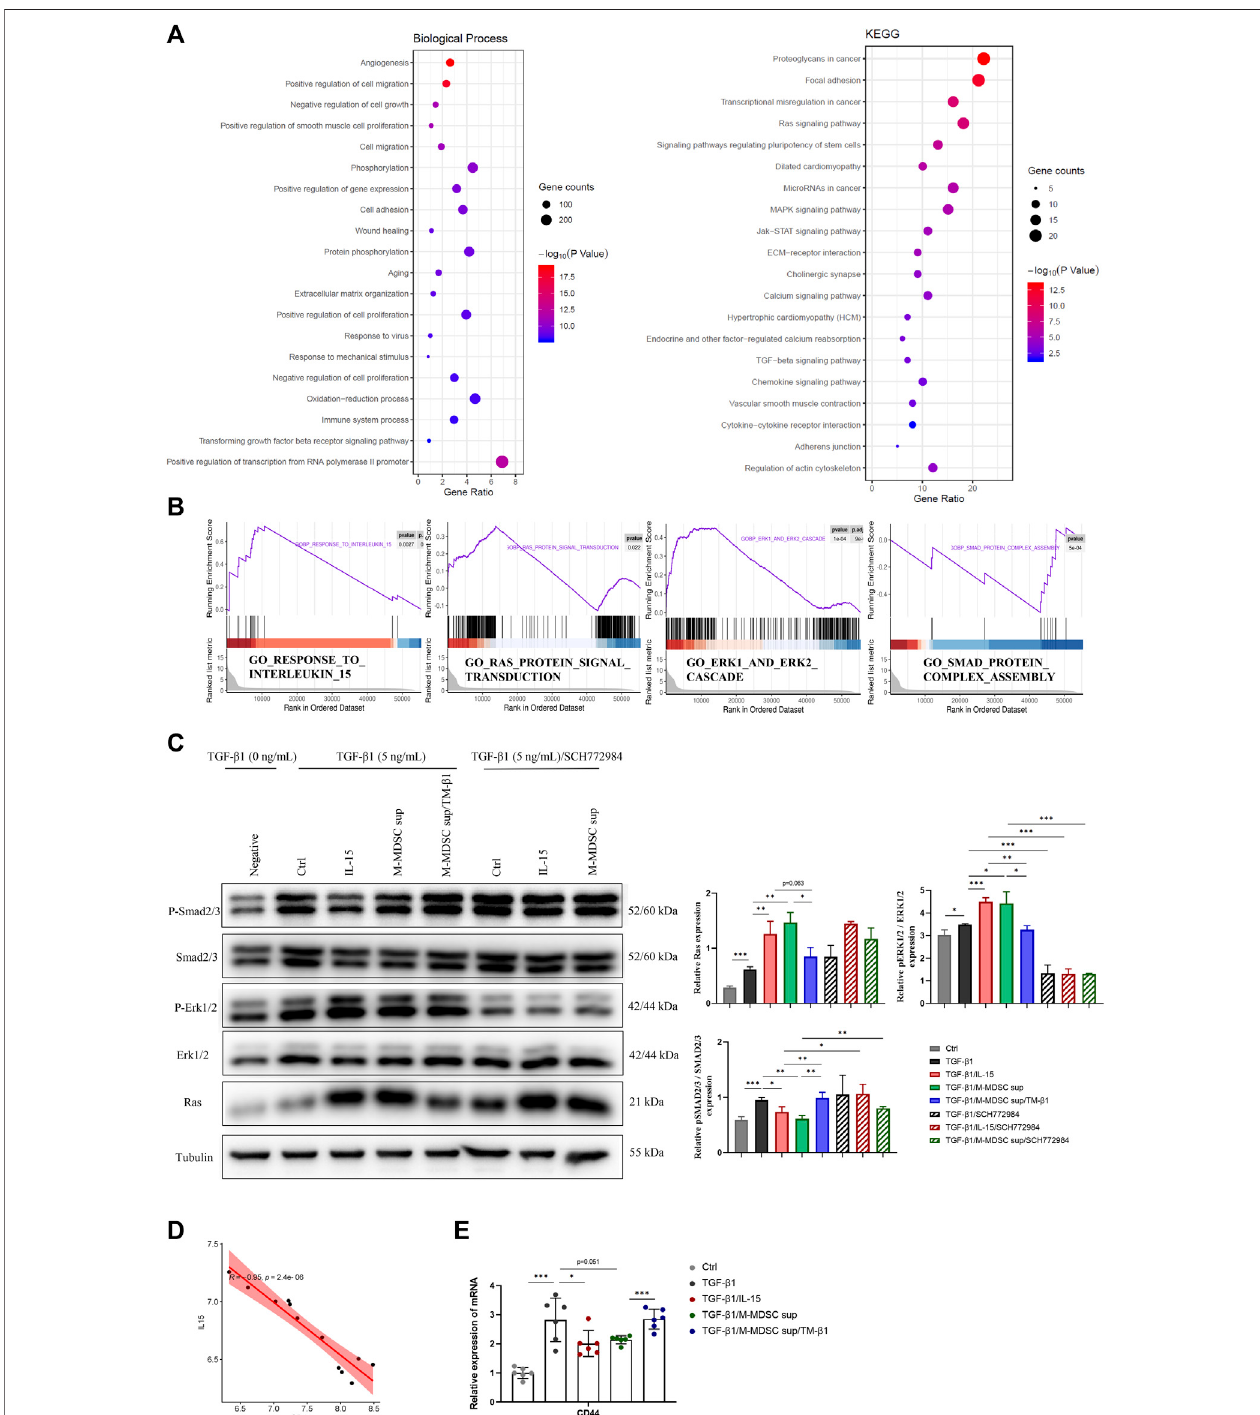
FIGURE 4 | The effects of M-MDSC supernatant on the myo fi broblastic differentiation of MSCs are mediated by IL-15-Ras-Erk1/2-Smad2/3 signaling. (A) Based on differentially expressed genes (DEGs) between MSCs treated with TGF- β 1 and MSCs treated with TGF- β 1/M-MDSC supernatant, theenrichmentitems were analyzed by Gene Ontology(GO)functionalannotationandKyotoEncyclopediaofGenesandGenomes(KEGG)pathwayanalysis. (B) Genesetenrichmentanalysis(GSEA)analysiswasperformed toscreensigni fi cantlyenrichedpathways. (C) MSCswereculturedwithTGF- β 1(5 ng/mL)for24 hwithorwithoutIL-15(1 ng/mL),M-MDSCsupernatant,TM- β 1(10 ng/mL) andSCH772984(10 μ M).TheproteinexpressionlevelsofRas,p-Erk1/2,Erk1/2,p-Smad2/3andSmad2/3weredetectedbywesternblotting.Valueswereexpressedasmean ± standarddeviation(mean ± SD). (D) TheexpressionofCD44wasinverselyrelatedtoIL-15expressioninthepublishedGSE83610dataset. (E) MSCswereculturedwithTGF- β 1 (5 ng/mL)for24 hwithorwithoutIL-15(1 ng/mL),M-MDSCsupernatantandTM- β 1(10 ng/mL).ThemRNAexpressionofCD44inMSCswasnormalizedtoGAPDHexpression. Values were expressed as mean ± standard deviation (mean ± SD). * p < 0.05; ** p < 0.01; *** p < 0.001.